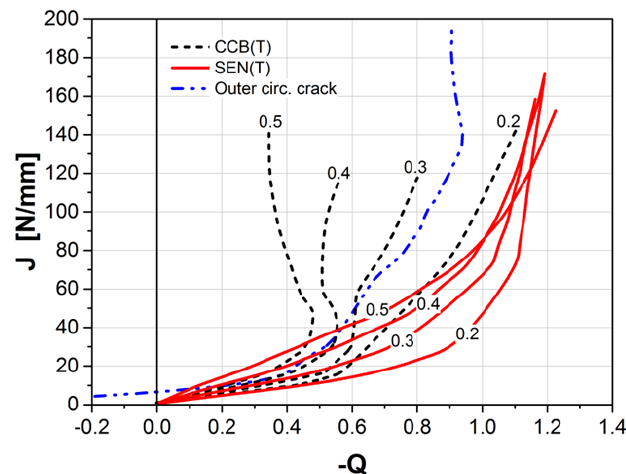
Figure 3: Comparison of the calculated J-Q paths for SENT and CCBT for different crack depth ratios. The J-Q path for a outer circumferential girth weld crack is also shown.